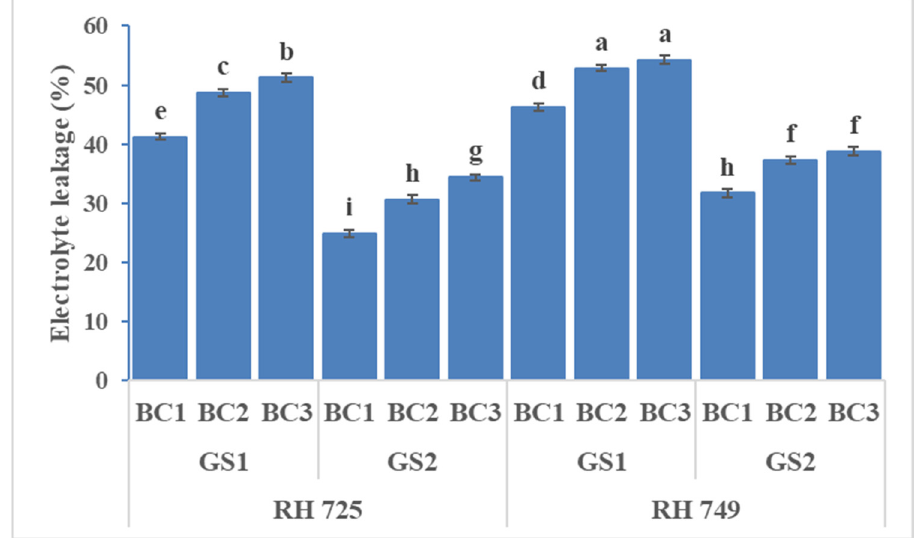
Figure 6. Comparisons of the effects of different concentrations of brassinolide sprays (BC1: control (water spray); BC2: 10 mg BRs/L water; BC3: 20 mg BRs/L water) on the electrolyte leakage (EL) concentration of drought-tolerant (RH 725) and drought-sensitive (RH 749) Indian mustard cultivars at the flower initiation (GS1) and 50% flowering (GS2) stages. Columns marked by different letters indicate significant differences ( p < 0.05) between treatments based on Duncan’s multiple range test. Error bars denote the standard errors of the mean.